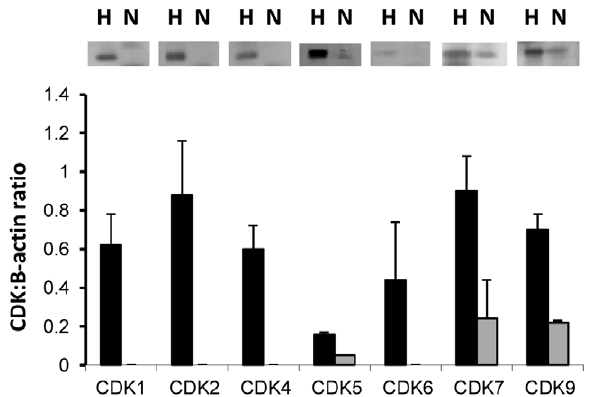
Figure 1. Human neutrophils express only cell cycle indepen- dent CDKs. Isolated human neutrophils (N) and promyelocytic HL60 cells (H) were assessed for expression of CDK proteins by western blotting (upper panel). Blots were scanned to determine the CDK: b - actin ratio by densitometry (lower panel; black bars = HL60, grey bars = neutrophils). Data are mean 6 s.d. for three separate cell extracts.